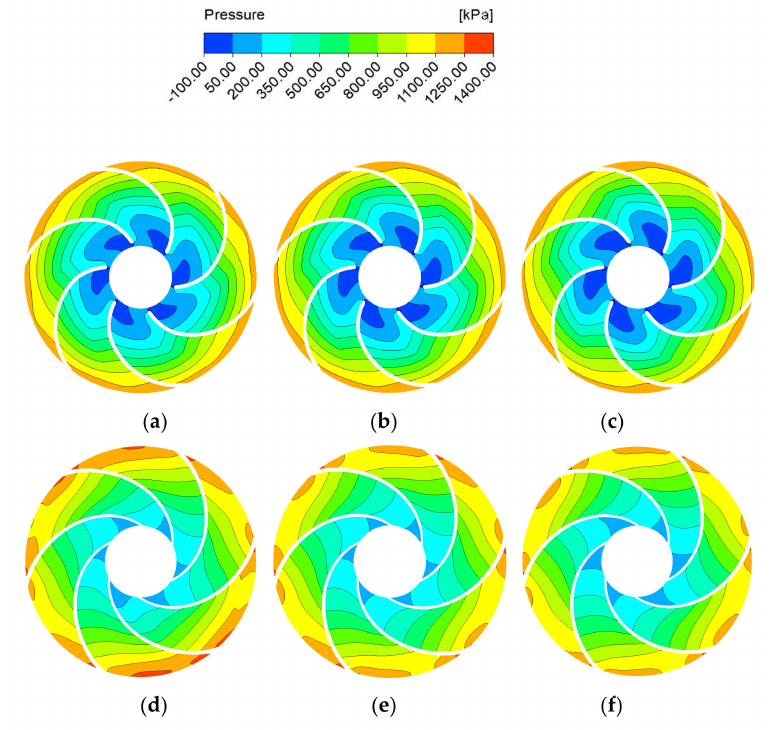
Figure 12. Comparison of static pressure distribution in the middle section of the impeller. ( a ) 0.8 Q d of the initial pump, ( b ) 1.0 Q d of the initial pump, ( c ) 1.2 Q d of the initial pump, ( d ) 0.8 Q d of the optimized pump, ( e ) 1.0 Q d of the optimized pump, and ( f ) 1.2 Q d of the optimized